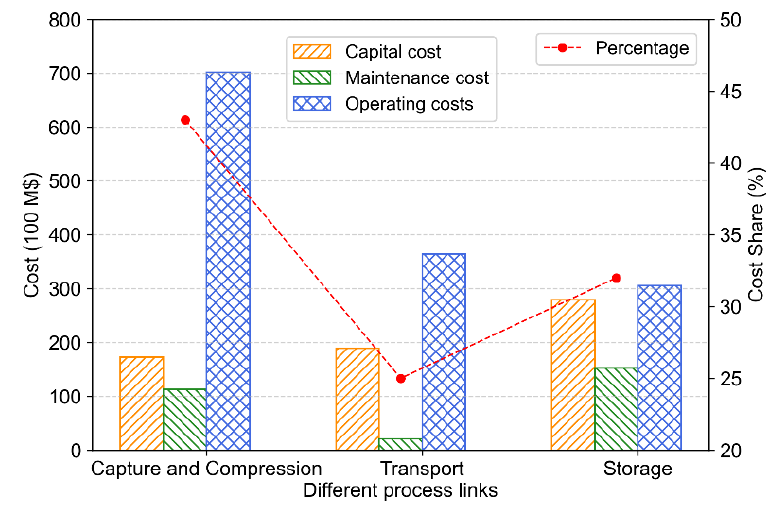
Figure 4. Cost and proportion of each process in the whole